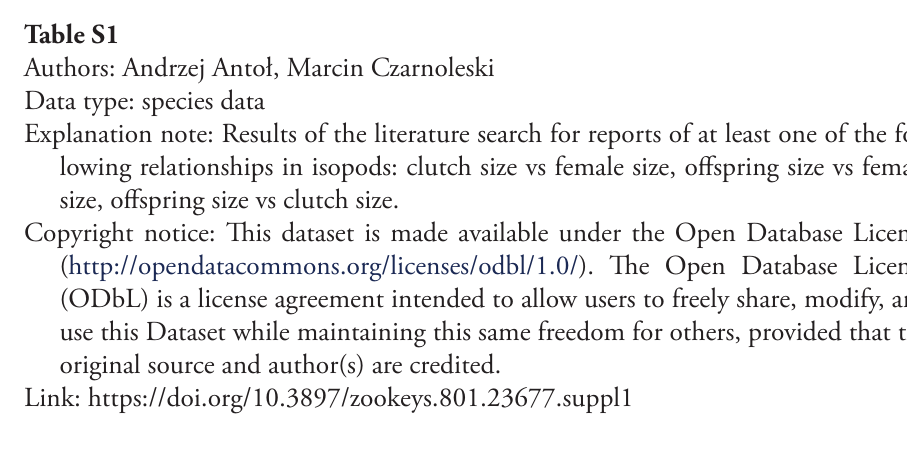
Data type: species